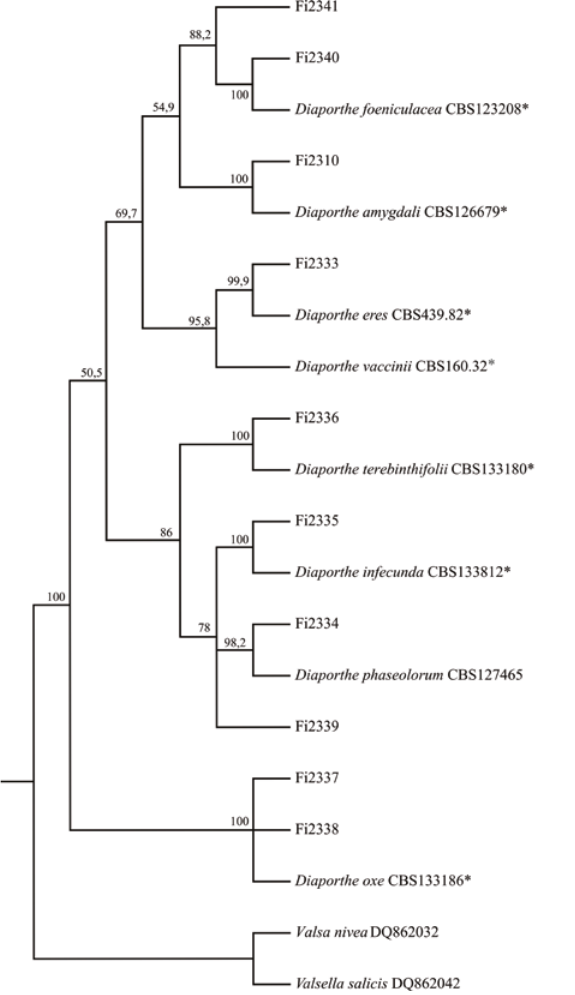
Figure 3. One of four most parsimonious trees resulting from the analysis of sequences of combined ITS and partial elongation factor 1 α (EF1-α) from fungal isolates. Maxi - mum-parsimony bootstrap support values based on 1,000 replicates are shown in the nodes. Ex-type isolates are highlighted with an asterisk. The tree is rooted with Valsa nivea (DQ862032) and Valsella salicis (DQ862042)